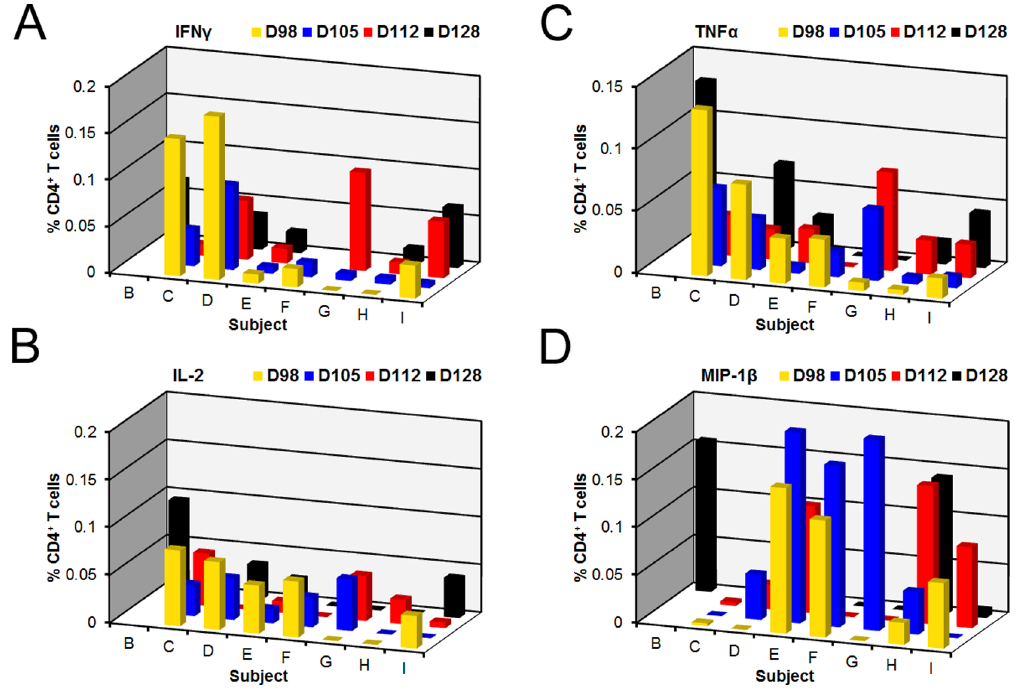
Figure 2. CD4 + T cell responses did not show a specific signature following re-challenge with the homologous C.jejuni strain. The effect of challenge on C. jejuni veterans shows a diverse T cell profile compared to naı¨ve subjects. Eight subjects were re-dosed with the homologous C. jejuni CG8421 strain three months after initial infection. We examined CD4 + T cell responses for the production of IFN c + , TNF a + , IL-2 + , and MIP-1 b at multiple timepoints pre- and post-re-infection. Responses shown are the percentage of cytokine positive CD4 + T cells from CAg-stimulated PBMCs with the background percentage of cytokine-positive T cells in the negative control (PBS) subtracted. D98 represents PBMCs from a blood drawn prior to re-infection. Bars represent percent of CD4 + T cells detected on specific days: D98 (day of re-dosing, yellow); D105 (blue); D112 (red); and D126 (black). No significant changes were observed post re-challenge compared to D98.